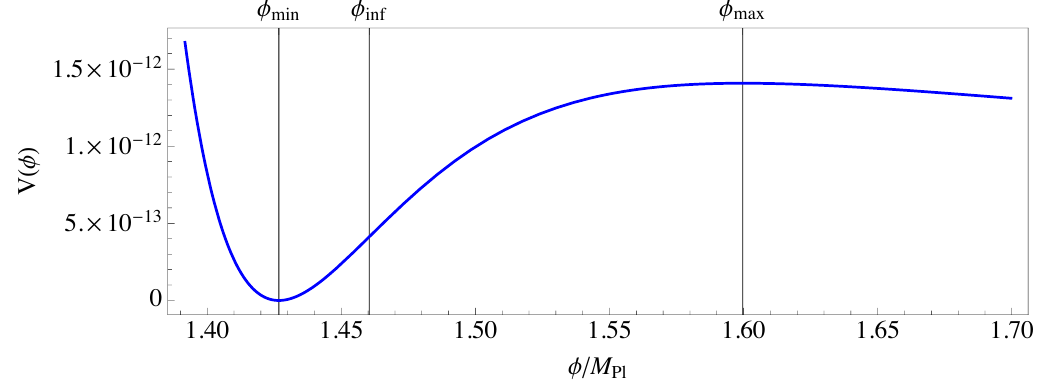
(cid:0) 5 A = 10 and a = 2 (cid:25) . 0 = 10